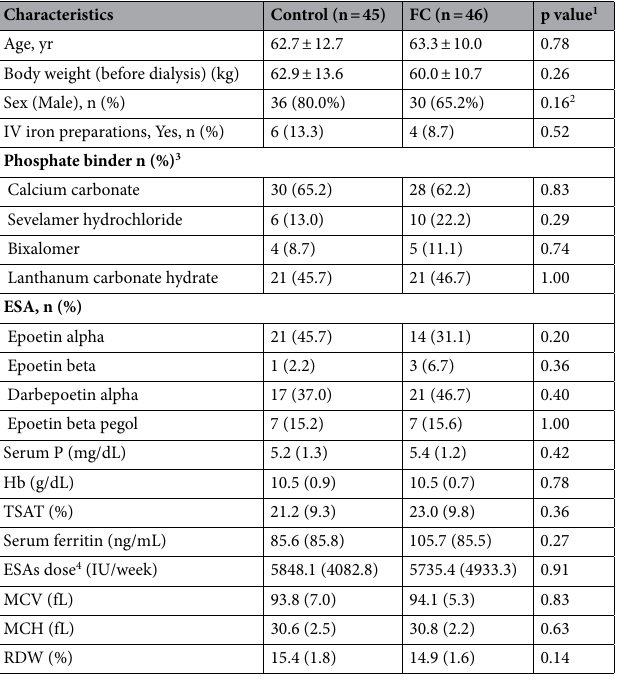
Table 1. Baseline characteristics. Values given as the mean ± standard deviation unless otherwise specified. 1) Student’s t test, 2) Fisher’s exact test, 3) Combination therapy were allowed. 4) Epoetin 200 IU =